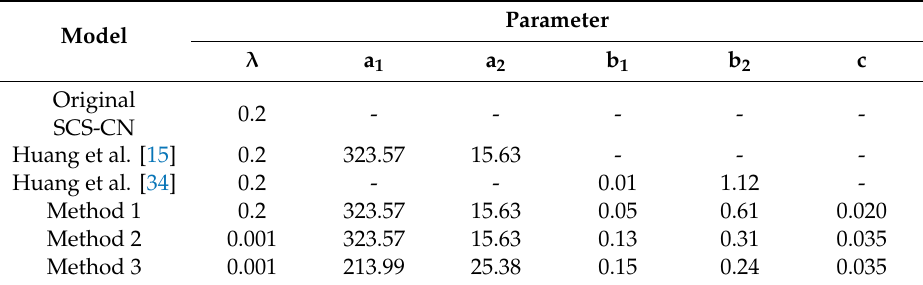
Table 2. The optimized parameters of the tested methods for the plots in XDG watershed. Model